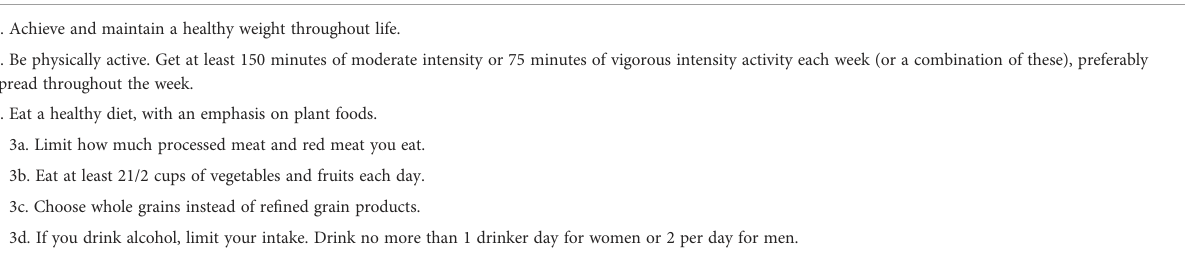
TABLE 1 The 2012 American cancer society guidelines on nutrition and physical activity for cancer prevention 1